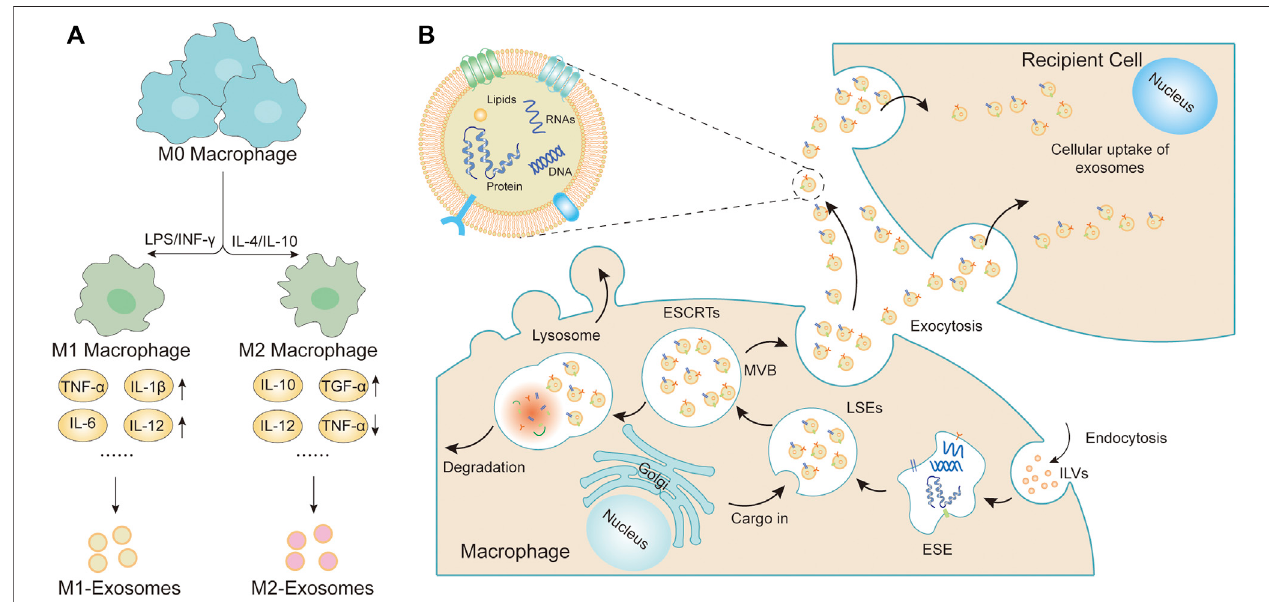
FIGURE1| MacrophagepolarizationandformationofsEVs. (A) M φ s couldberoughlydividedintotwosubtypes(M1 M φ s andM2 M φ s )dependingonthedifferent microenvironmental stimuli. M1 M φ s are typically induced by IFN- γ or LPS while M2 M φ s are induced by IL-4 or IL-10. M1 M φ s -sEVs secrete high levels of proin fl ammatorycytokines,suchasTNF- α ,IL-1 β ,IL-6,IL-12,andIL-23,promotingthein fl ammatoryandcytotoxicresponses.M2 M φ s -sEVscannotonlydirectlyinhibit pro-in fl ammatory enzymes and cytokines, such as IL-12 and TNF- α , to achieve anti-in fl ammatory effects but can also display higher levels of certain anti- in fl ammatory factors, such as IL-10 and TGF- β , thereby resolving deleterious in fl ammatory conditions. (B) The cytoplasmic membrane of the M φ s initially invaginates to form endocytic vesicles, and multiple endocytic vesicles fuse to form early-sorting endosomes (ESEs). The ESEs then invaginate, encapsulating intracellular material in theprocess,furthertransformingintolate-sortingendosomes(LSEs),whichareknownasmultivesicularbodies(MVBs).MVBsthenfusewiththecytoplasmicmembrane and releases EVs into the extracellular